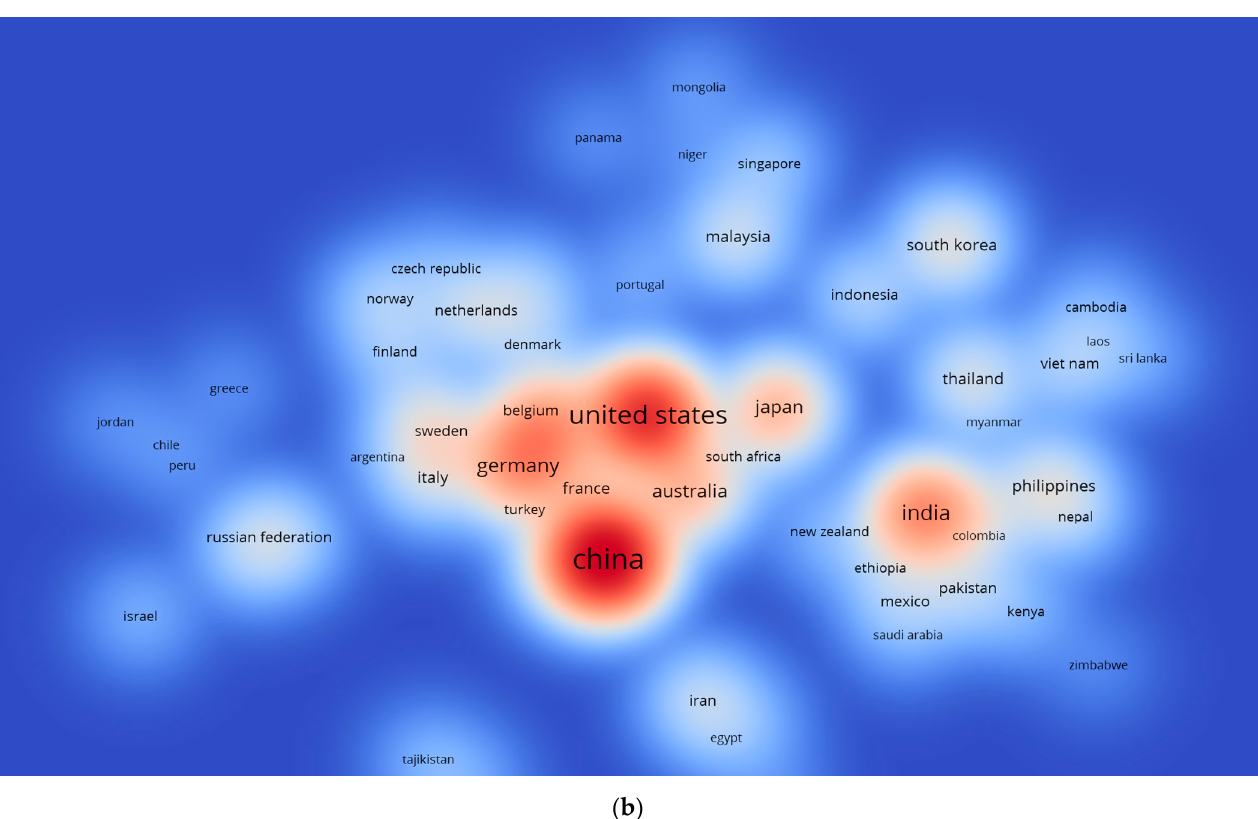
Figure 6. ( a ) . Countries visualization with maximum contributions to drought analysis; green: India, Nepal, Kenya. Yellow: Israel, USA, Germany. Blue: Indonesia, Thailand, Myanmar. ( b ). Density visualization with maximum contributions to drought analysis. Table 3. Countries mapping .